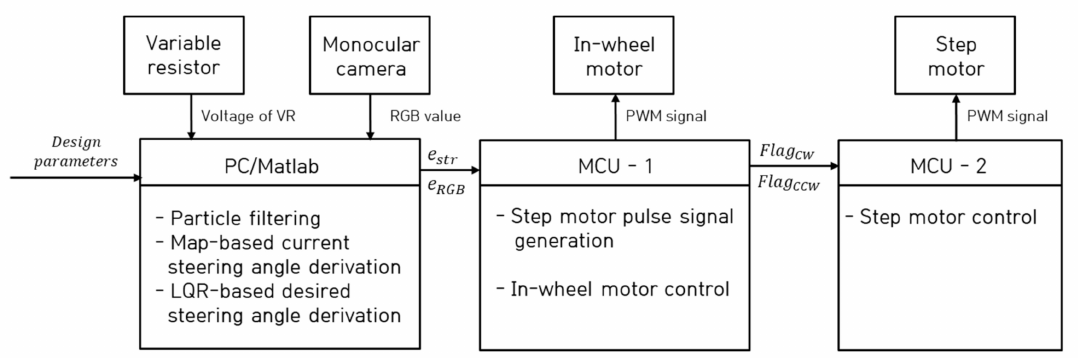
Figure 6. Block diagram for an autonomous truck with a single steering and driving